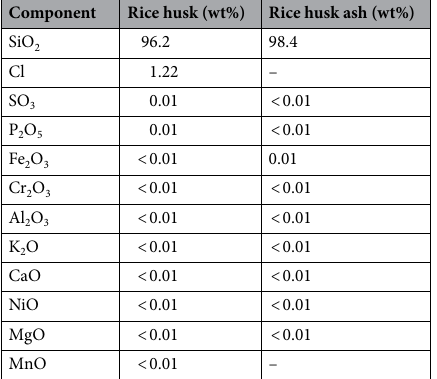
Table 1. X-ray fluorescent analysis showing the chemical composition of acid leached UKMRC-8 rice husk and rice husk ash.